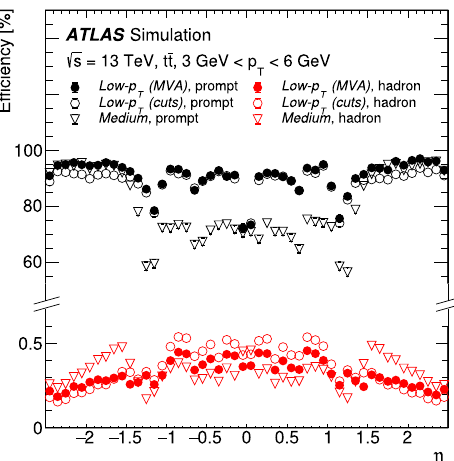
that are associated with a reconstructed muon passing the given WP requirements. The ID tracks are matched, respectively, to generator- level prompt muons or light hadrons. Both the cut-based and multivari- ate Low - p T WPs are